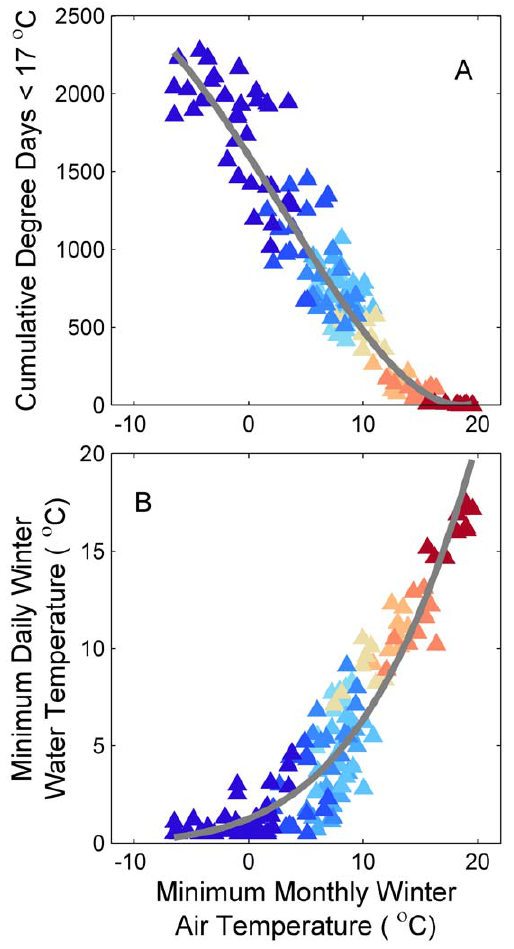
Figure 2. Relations between winter water temperature and air temperature in 12 estuaries along the east coast of the United States. Points represent winter temperatures in a given year in a given estuary. Estuarine water temperatures are expressed as (A) cumulative degree days , 17 u C and (B) minimum daily winter temperature (Dec- Mar). Air temperature is expressed as minimum monthly mean winter temperature. Gray line represents the least squares regression fit based on eq. 3. Color of the symbol represents the latitude of the source estuary for the water temperature data (see Figure 1).